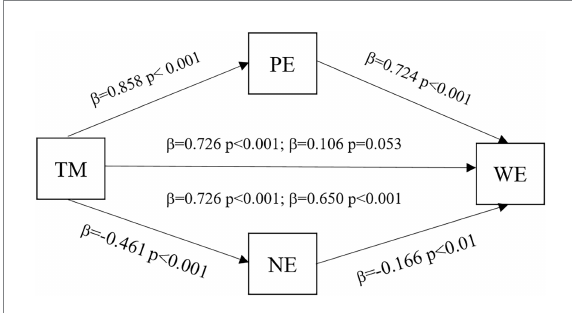
FIGURE 2 The effect of teacher mindfulness on work engagement and the mediation of classroom